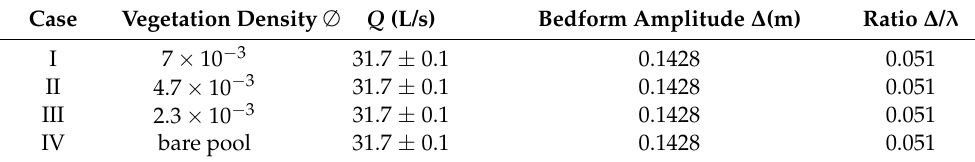
Table 1. Experimental conditions.